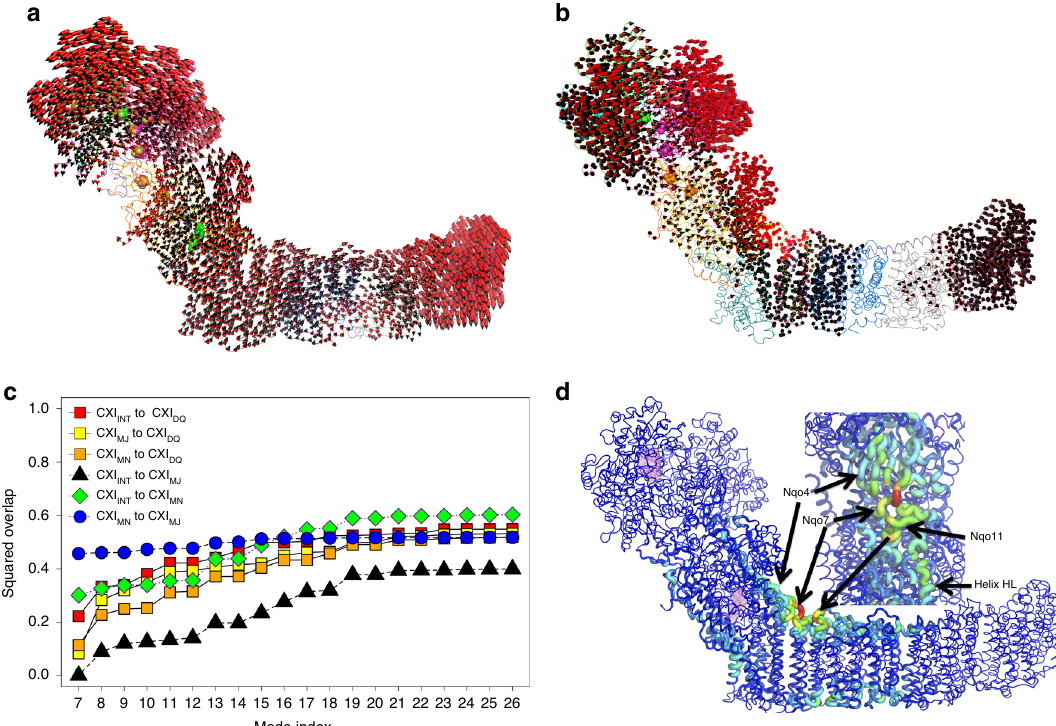
Fig. 7 The results of normal mode analysis (NMA). Both lowest-frequency modes, mode 7 a and mode 8 b , bending and rotation respectively, are observed experimentally. The overlap analysis c shows that transitions to CXI DQ conformation involve a large contribution of rotational motions (mostly mode 8 plus some additional modes), which is not the case for transitions between unliganded conformations, the CXI INT → CXI MN and CXI MN → CXI MJ . The CXI INT → CXI MJ transition features no bending motion (mode 7) at all, but residual, localized rotational motions of higher frequency. The results of deformation analysis d identify the most fl exible parts of complex I: the long loop of the Nqo7 subunit at the junction between PA and MD, as well as part of Nqo12 traverse helix HL, both involved in almost all of the fi rst 20 motions (modes), which characterize the essential dynamics of complex I. The inset shows the view from